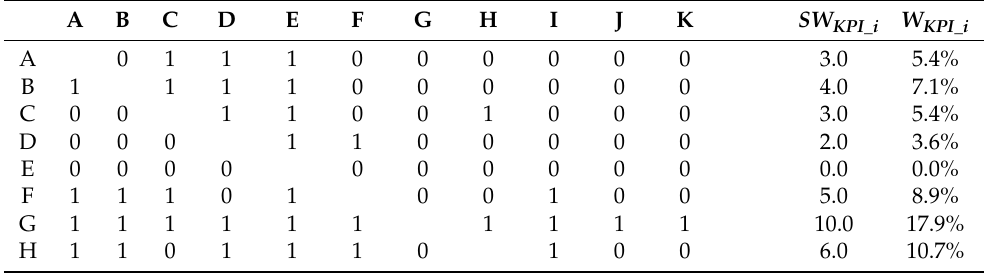
Table A3. KPI comparison matrix with weights (Scenario